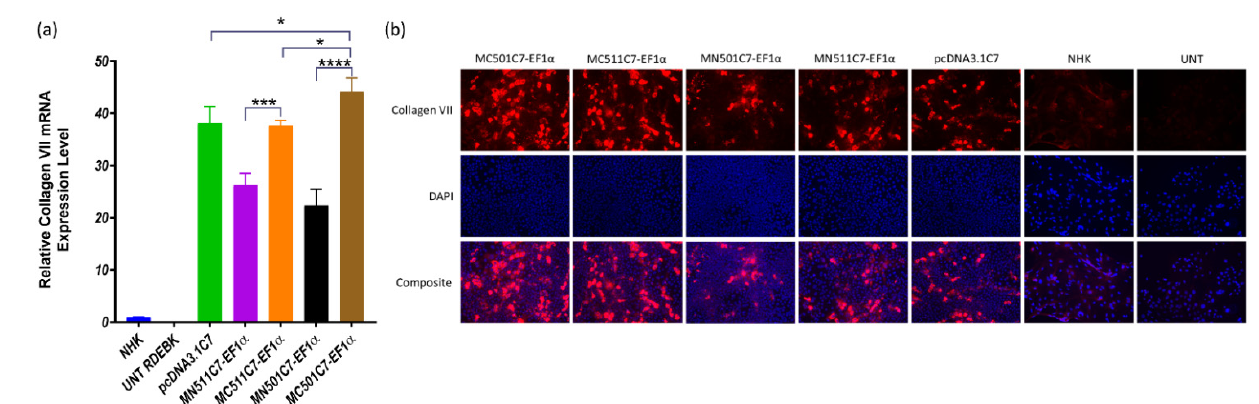
Figure 5. COL7A1 transcription and protein expression. ( a ) COL7A1 gene transcription level of RDEBK cells treated with MN501C7-EF1 α , MC501C7-EF1 α , MN511C7-EF1 α . MC511C7-EF1 α , and pcDNA3.1DNA plasmids were compared by RT-qPCR. Data were collected from 3 replicates of 3 independent experiments and presented as means ± SD ( n = 3). **** p < 0.0001, *** p < 0.001, * p < 0.05, as compared between the different treatment conditions, normal human keratinocytes and RDEBK cells were used as positive and negative controls respectively. ( b ) Immunocytochemistry images were taken 48 h after transfection, using a 20 × fluorescence microscopy objective. C7 was stained with anti-C7 antibody and AlexaFluor™ 568-labeled antibody, and the nucleus was stained with DAPI. Fluorescence microscopy images are representative of three independent experiments ( n = 3).